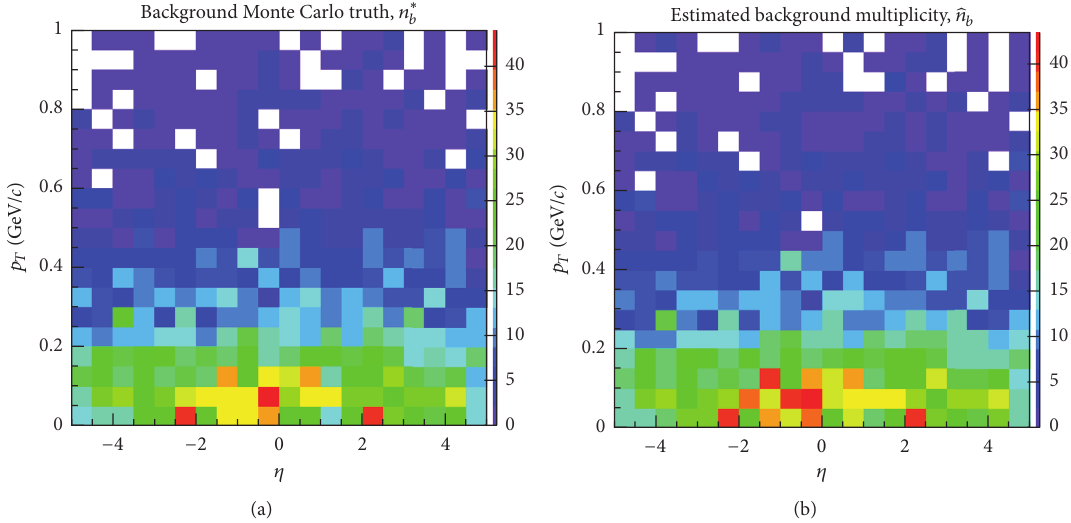
Figure 4: (a) True particle-level (𝜂,𝑝 𝑇 ) distribution of neutral soft QCD particles corresponding to one of the Monte Carlo events generated in this study. The plot illustrates how the soft QCD particle multiplicity across the kinematic space inside a typical event deviates from the corresponding probability distribution due to the limited particle statistics. (b) The corresponding particle-level (𝜂,𝑝 𝑇 ) distribution of neutral soft QCD particles estimated using this algorithm as described in the text.